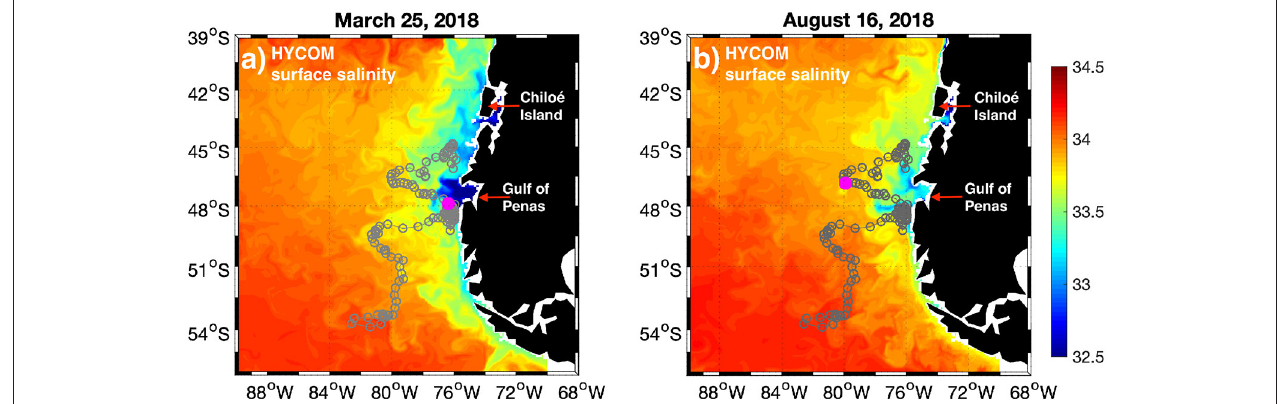
FIGURE 1 | Maps of surface salinity from HYCOM global model on (a) March 25, 2018, and (b) August 16, 2018. The gray circles denote the trajectory of BGC Argo float 5904663 from December 8, 2015 (offshore, southwest limit) to July 3, 2019 (nearshore, north of Gulf of Penas). The magenta dot shows the location of the float on the same date of the corresponding HYCOM salinity